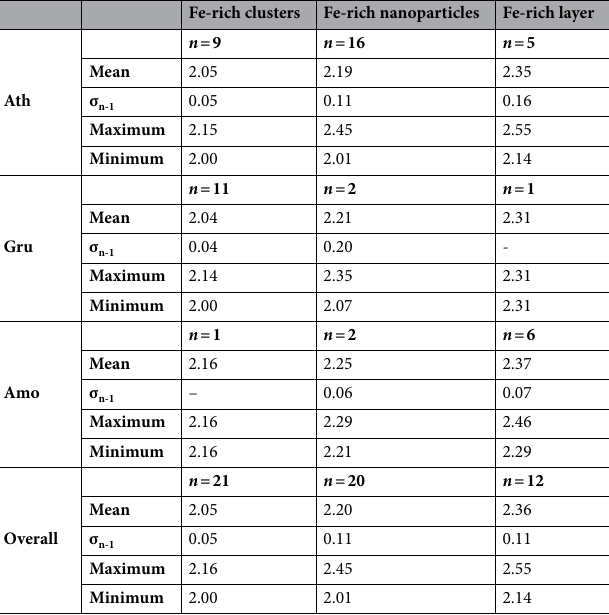
Figure 5. Experimentally determined (blue) and calculated (log-normal fits; grey) size distributions of clusters and nanoparticles occurring in the amorphous Fe-rich layer on amphibole particles extracted from AECs, indicating an abiogenic or BIM process of particle formation. ( a ) size distribution of clusters on a grunerite particle; ( b ) size distribution of nanoparticles on an anthophyllite particle. The x-axis labels show the upper limit of each bin (10 bins total for each chart). Fe-rich clusters Fe-rich nanoparticles Fe-rich